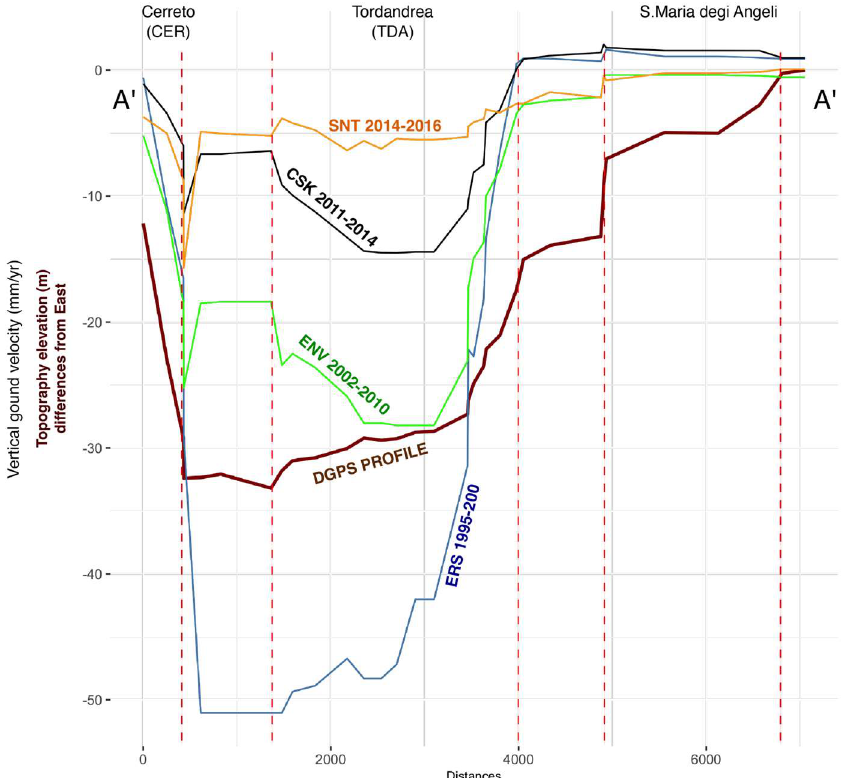
Figure 7. (Upper panel) Topographic and velocity profiles: the brown line is the elevation profile of the valley along A-A’ (Figures 3c and 6d), and the blue, green, black and orange lines are the ERS, ENV, CSK and STN satellites’ ground vertical velocities profiles, respectively, along the same profile. In the Y-axis, the values express both the mm/year of vertical velocities of ground displacement and the height differences, in meters, measured along the profile A-A’ with respect to the initial point A. The red dashed lines (see Figure 6d) identify the orographic steps along the profile that are correlated to the changes in ERS, ENV, CSK and SNT ground velocities measured along the same elevation profile trace (horizontal vs. vertical scale is 1:100).